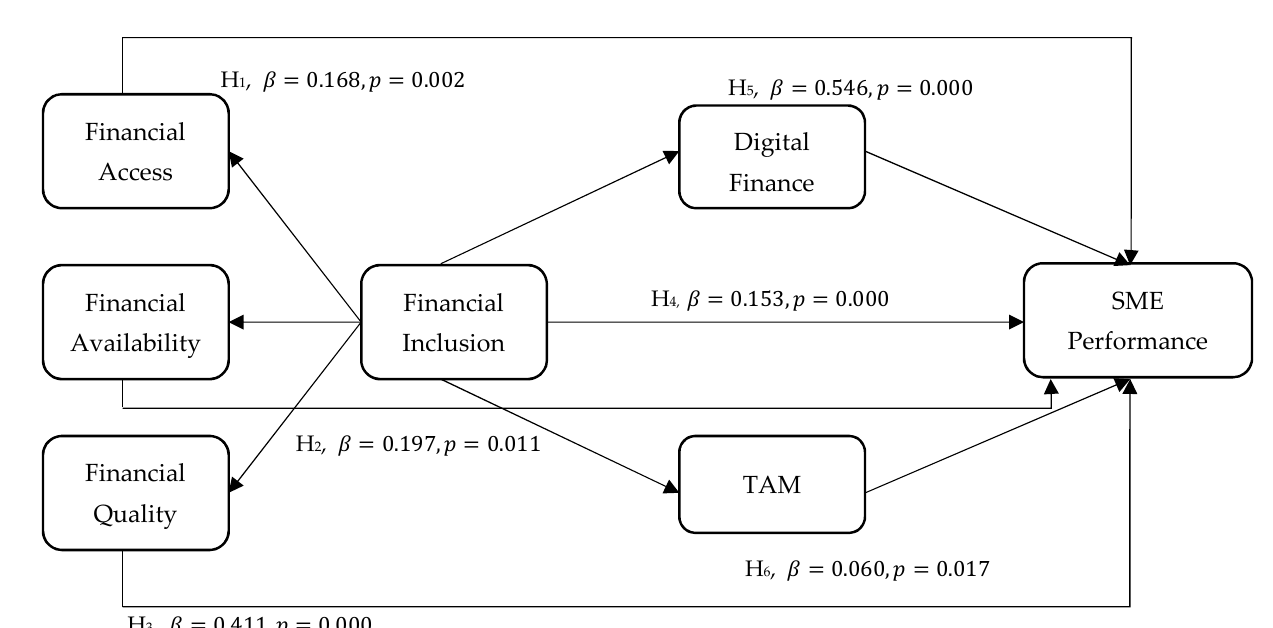
Figure 2. Direct path coefficient in SME. Source: Author’s calculation.